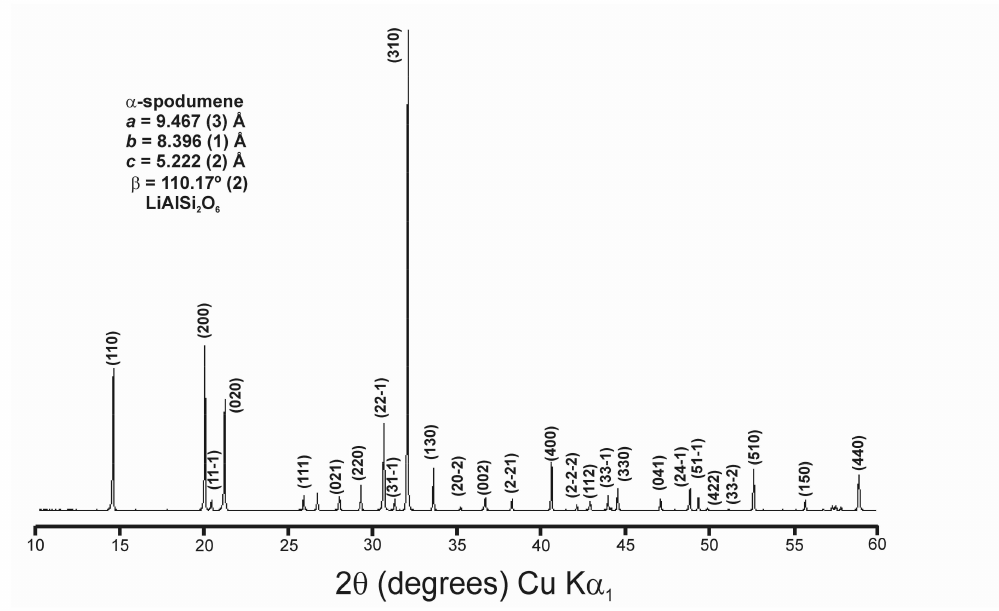
Figure A1. Powder XRD pattern of α - spodumene LiAlSi 2 O 6 with a = 9.467 (3) Å, b = 8.396 (1) Å and c = 5.222 (2) Å, α = 90 ◦ , β = 110.17 ◦ (2), and γ = 90 ◦ , with (hkl) from the model C 2/c space group in specimen Golconda , with cell parameters very similar to file CC 9668 in ICSD database, with a = 9.449 (1) Å, b = 8.386 (1) Å and c = 5.215 (2) Å, α = 90 ◦ , β = 110.10 ◦ (2), and γ = 90 ◦ .